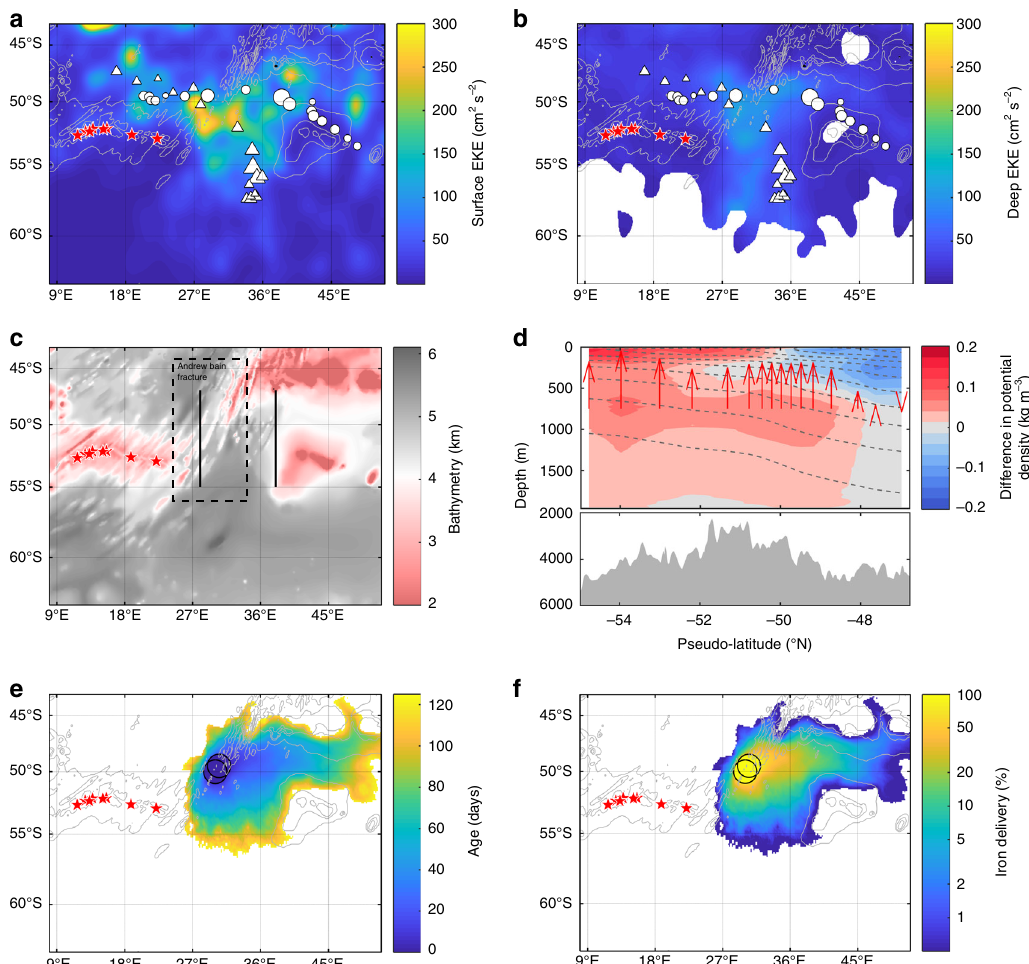
Fig. 4 Topographically upwelled waters in the vicinity of the Antarctic Circumpolar Current along the SWIR. Maps of the eddy kinetic energy (EKE) at the surface ( a ) and at depth ( b , approximately 1000 meters). The surface EKE was derived from altimetry-derived velocities (AVISO MADT daily product) over the 2003 – 2017 period. The deep EKE was calculated from the Argo-derived velocities during their parking depth and available in the ANDRO dataset (2000 – 2016). The maximum depth-integrated biomass (mg Chl a m − 2 ) is also depicted according the size of the dots (triangle: fl oat WMO 6901585 and circle: fl oat WMO 2902130). c Maps of bathymetry of the SWIR, the Andrew Bain fracture zone (as indicated by the dashed box; http://www. marineregions.org/gazetteer.php?p = details&id = 7253) and the two meridional sections at 28°E and 38°E (between latitude 47° – 55°S; plain black lines) where the difference in potential density Δ σ shown in panel d was determined. d Climatological difference of potential density, Δ σ , between the two meridional sections at 38°E and 28°E in the upper 2000m (between latitude 47° – 55°S). Gray shading represents the mean bottom topography between 28 and 38°E, and the red arrows are provided to show the sense of downstream isopycnal adjustment at 750-m depth. The difference in Δ σ is an alongstream difference across the two sections, which is converted back to latitude for ease of reading (therefore referred to as pseudo-latitude). See the Methods for more details. e – f Satellite altimetry-derived Lagrangian modeling of the iron pathways from the departure of the SWIR as shown in e age (days since having left the SWIR) and in f iron delivery. Black circles in e – f indicate the origin of the iron pathways in the surface layer. The red stars in a – c, e and f are related to the position of hydrothermal vents from Tao et al. 14 . The continuous and dashed gray lines indicate, respectively,